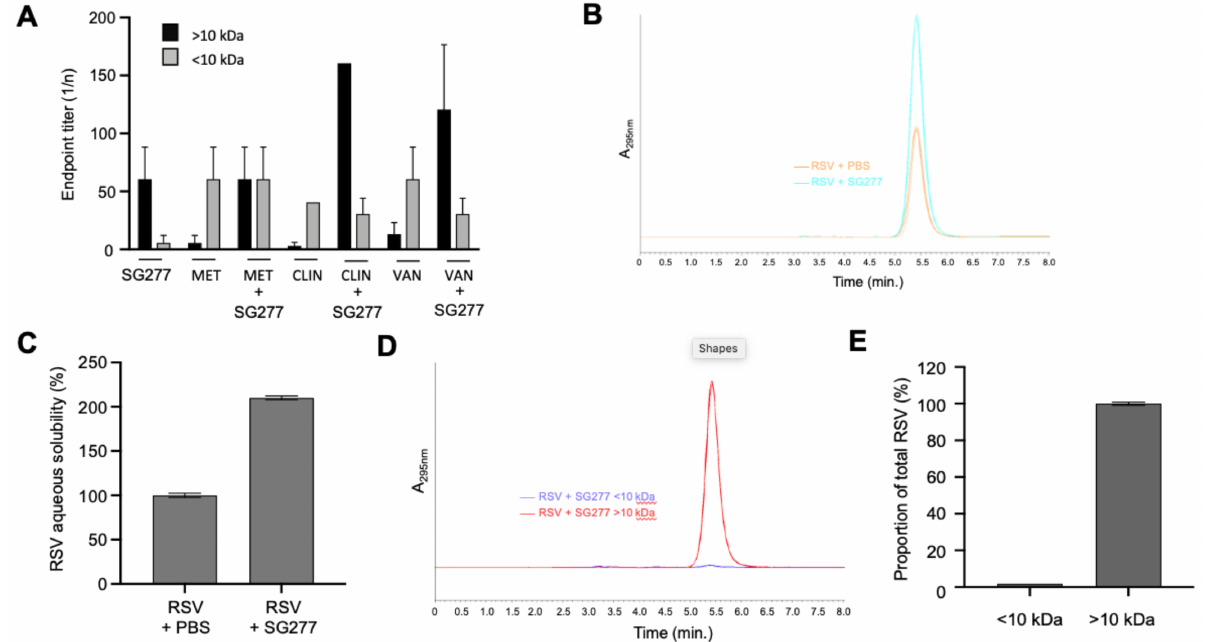
Figure 7. Micellar incorporation of antimicrobials. ( A ) SG277 AmSO 4 material comprising micelles ( mic ) was mixed with either metronidazole (MET), clindamycin (CLIN) or vancomycin (VAN) and then filtered through a 10 kDa membrane. Inhibitory activity towards CD630 in the eluate (<10 kDa) was determined and compared to the starting solution. Antibiotics without the addition of micelles were taken through the same procedure for comparison. ( B , C ) SG277 SEC material or PBS were combined with resveratrol (RSV), incubated at RT and insoluble material was pelleted by centrifugation. ( B ) The supernatants containing solubilised resveratrol were analysed by RP-HPLC for resveratrol. ( C ) The absorbance was used to determine the aqueous solubility of resveratrol in SG277 SEC material as a proportion of resveratrol’s solubility in PBS. The experiment was performed 3-times. ( D , E ) SG277 SEC material was combined with resveratrol, incubated at RT and insoluble material was pelleted by centrifugation. ( D ) The supernatant was then filtered through a 10 kDa membrane and the eluate (<10 kDa) and retentate (>10 kDa) were analysed by RP-HPLC for resveratrol. ( E ) The absorbance was used to calculate the proportion of RSV in the eluate (<10 kDa) and retentate (>10 kDa). The experiment was performed